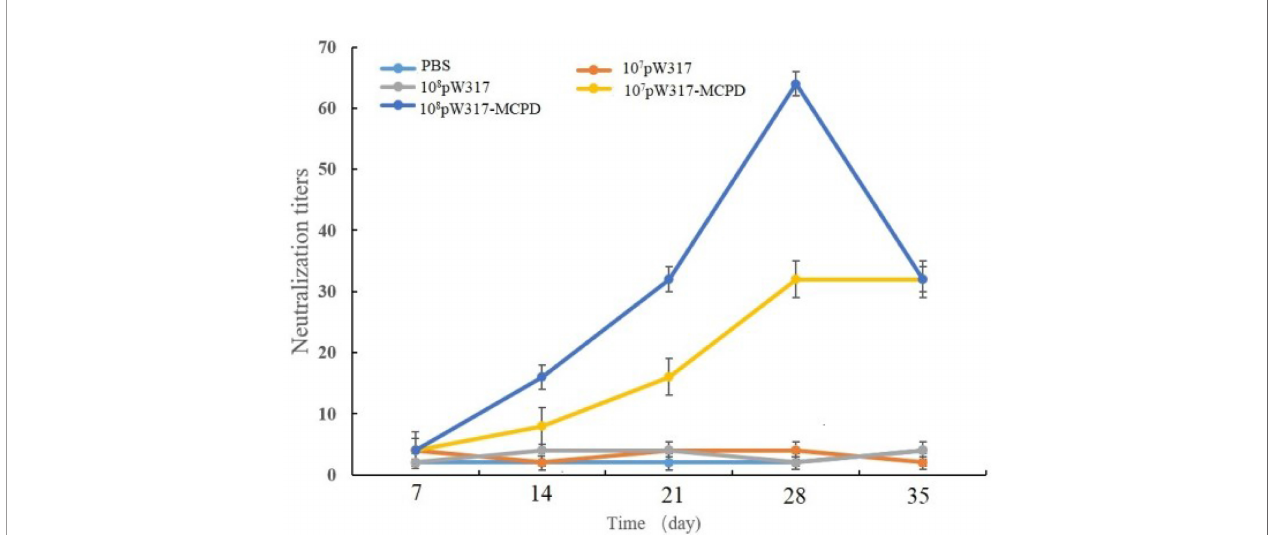
FIGURE 8 | Serum neutralization assay of largemouth bass after oral immunization. Note: 10 7 pW317: 10 7 CFU/g GS115-pW317; 10 8 pW317: 10 8 CFU/g GS115- pW317; 10 7 pW317-MCPD: 10 7 CFU/g GS115-pW317-MCPD; 10 8 pW317-MCPD: 10 8 CFU/g